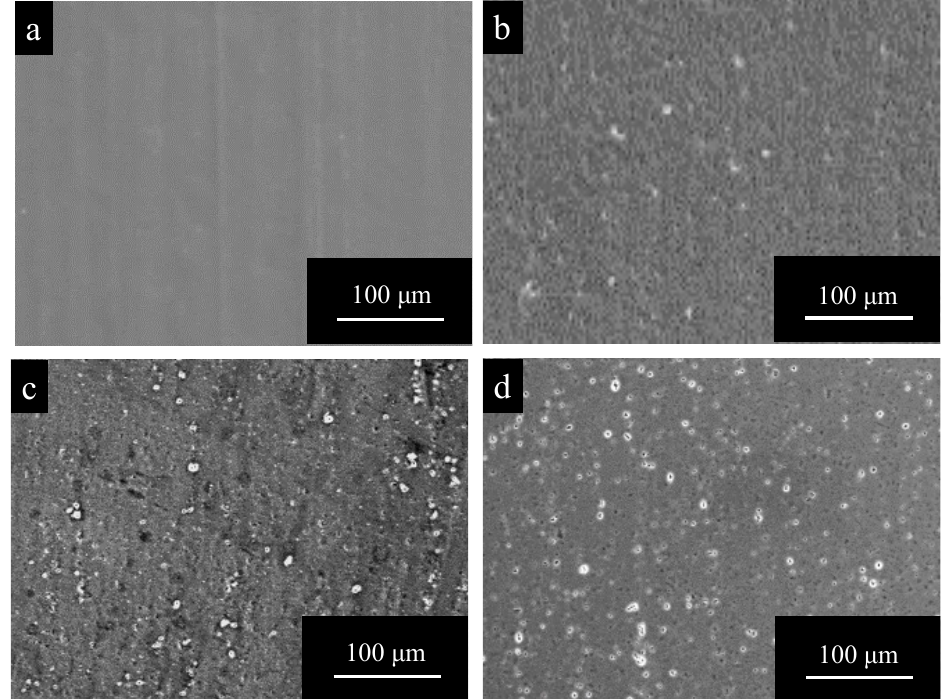
Figure 2. SEM images of surfaces of ( a ) pure Al, ( b ) 1050-al alloy, ( c ) 3003-Al alloy, and ( d ) 5052-Al alloy specimens after electropolishing ( t a = 0). ( c ) enlarged to 500% can be found in Figure A1 in the Appendix A.